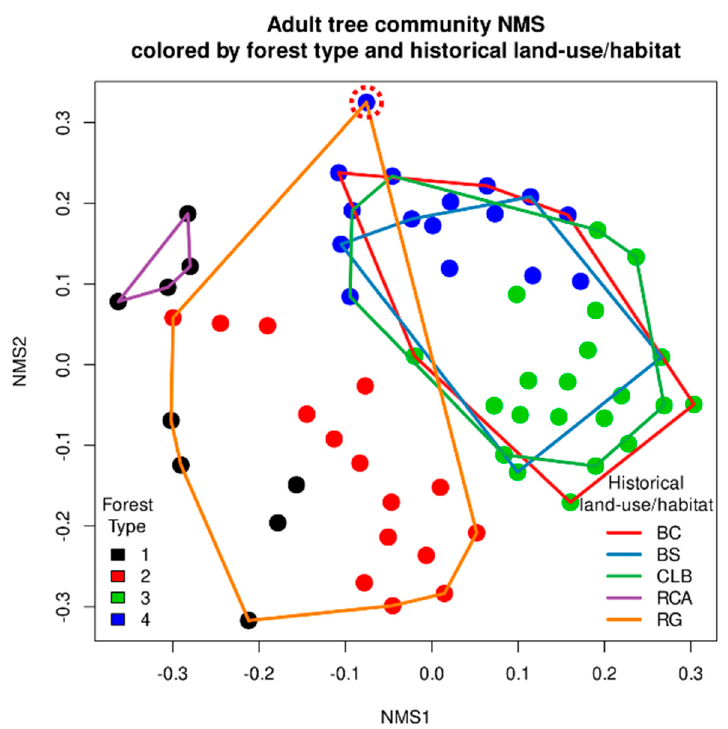
Figure 5. Nonmetric multidimensional scaling (NMS) ordination of adult tree communities using Bray–Curtis dissimilarity. Kruskal’s stress = 0.29. Both land-use history (hulls) and current ecological state (“Forest Type”, point fill color) are noted. Site circled with a red-dotted line represents site 10.1, which was historically pastured but regenerated to resemble an “old” forest type IV.